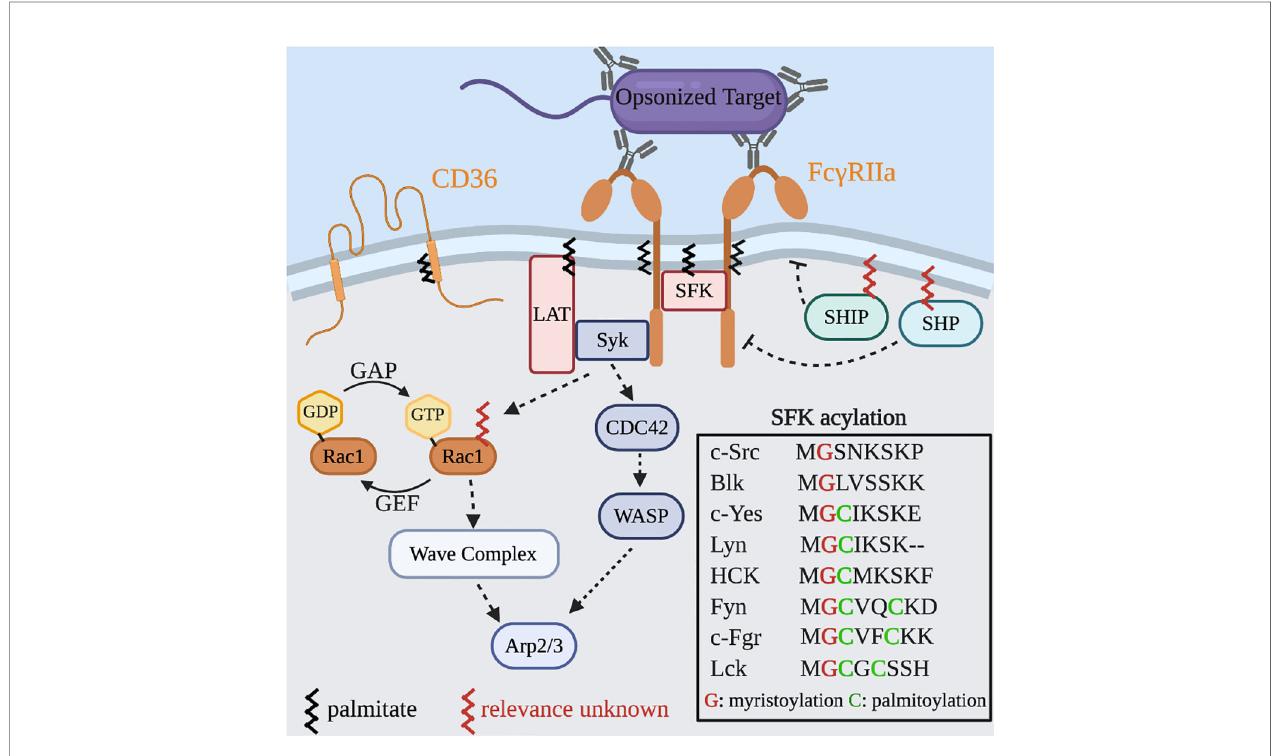
FIGURE 3 | S -acylated proteins in Fc g receptor signaling and actin dynamics. Binding of IgG to the Fc g R leads to localized clustering and signal transduction. Phosphorylation of the ITAM motifs and SFKs generates binding sites for Syk and the recruitment of LAT which together amplify the signal intensity. Additional downstream signaling leads to GTP-loading of both Cdc42 and Rac1 that results in Wiskott – Aldrich syndrome protein (WASP) and WASP-family verprolin homologous protein (WAVE) complex mediated actin rearrangements to drive particle engulfment. Two phosphatases, SHP and SHIP, serve as negative regulators of phagocytosis and are recruited by binding the inhibitor Fc g RIIb and may also require S -acylation for their activity. Inset: All SFKs are myristoylated and most are